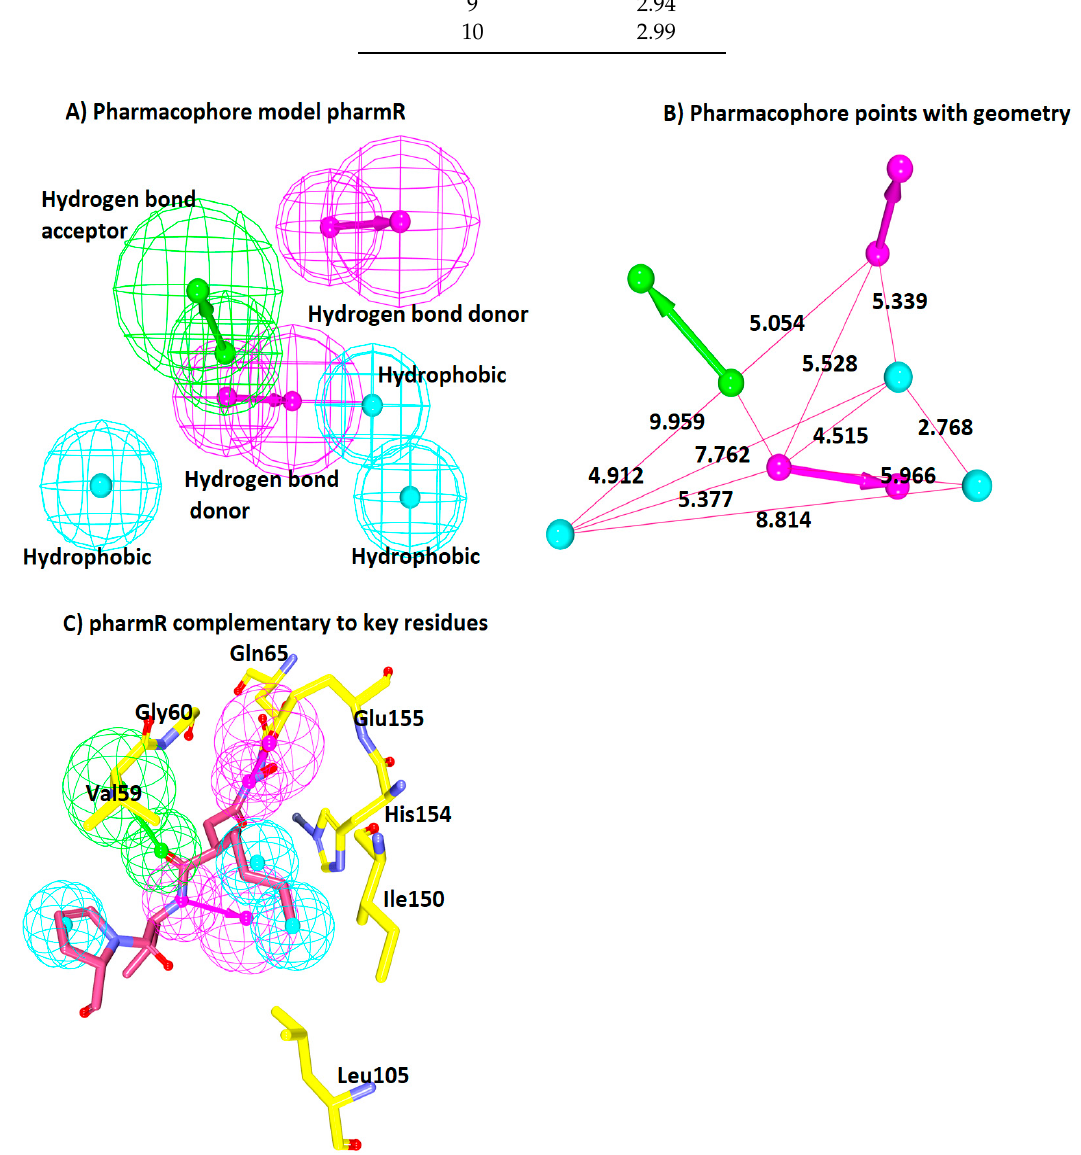
Figure 3. Receptor-based pharmacophore model generation. ( A ) A six-feature model pharmR consisting of three hydrophobic (HyP), two hydrogen bond donor (HBD), and one hydrogen bond acceptor (HBA). ( B ) Geometric interface distance between the features. ( C ) Key residues (yellow) complementary to the pharmacophore features. Pink line and stick represents the inbound